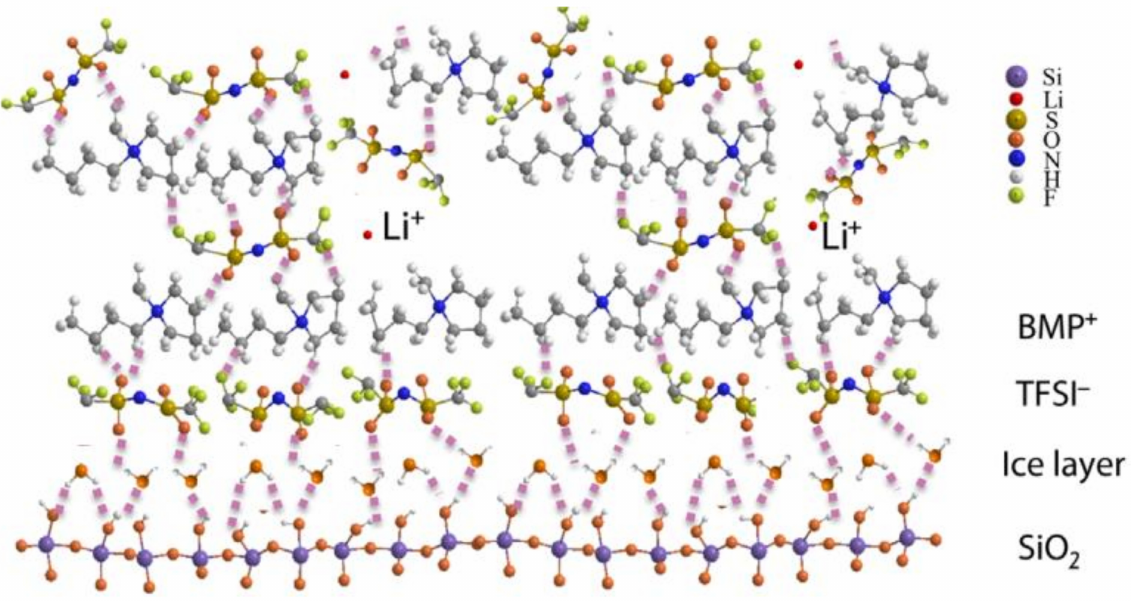
Figure 17. The model of the electrolytic conductance on the inorganic filler (SiO 2 ) interfaces through the layers of immobile ice layer absorbed on OH-terminated silica surface. Reprinted with permission from Chen et al. [138]. 2020 Creative Commons Attribution-Noncommercial